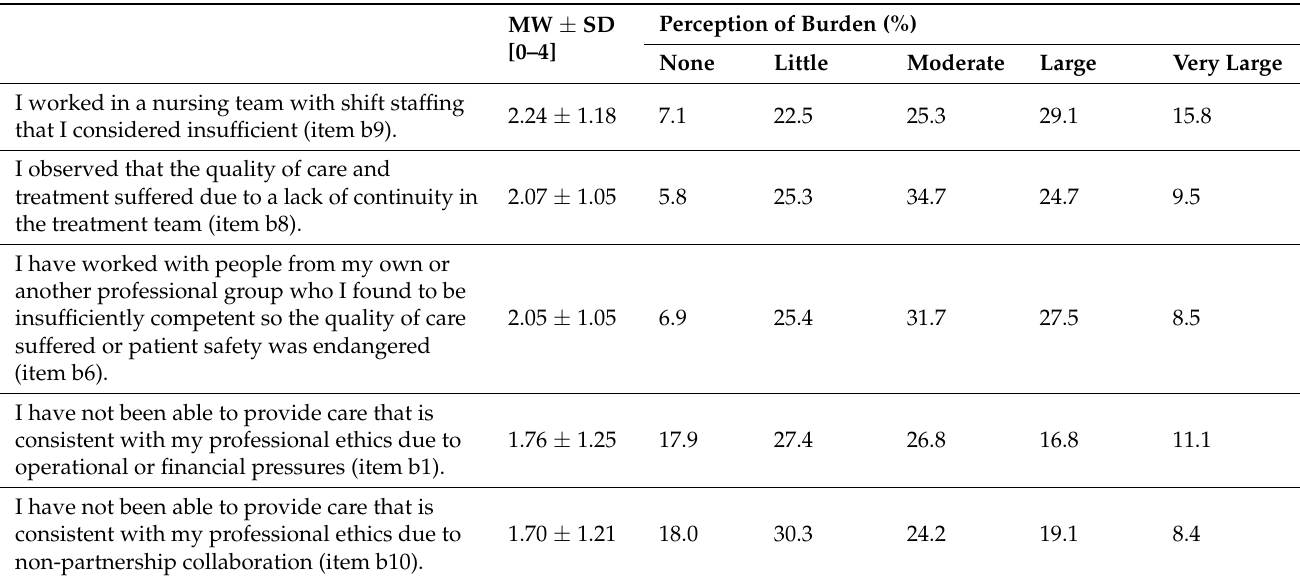
Table 2. Particularly stressful situations for